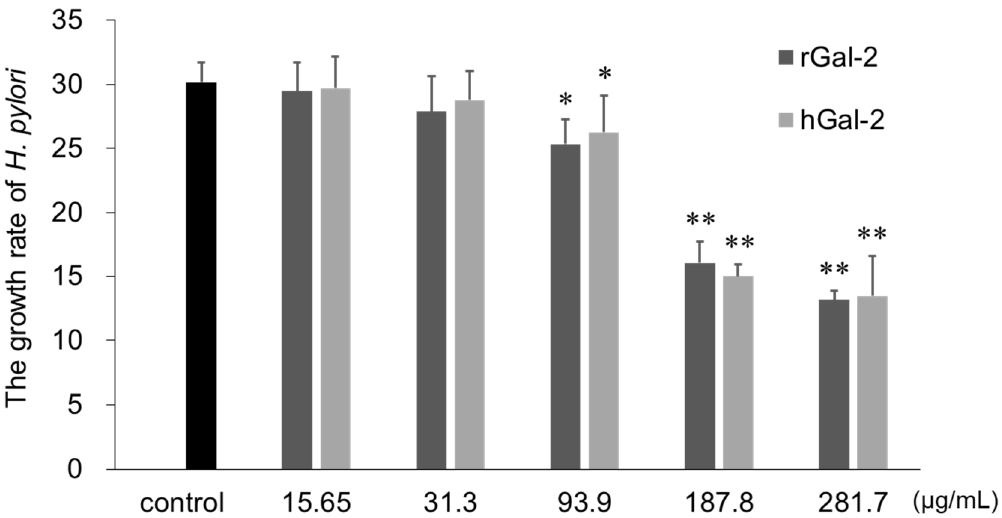
Figure 4. Inhibitory e ff ect of Gal-2 on H. pylori growth. The growth rate of H. pylori is represented as the optical density ratio at 600 nm (OD 600 ) before and after incubation for 3 days. The black, dark gray, and light gray bars represent control (without Gal-2), rGal-2, and hGal-2, respectively. Mean ± SD of the results obtained from four samples. *, p < 0.05; **, p < 0.01 by Dunnet’s test (vs. control).